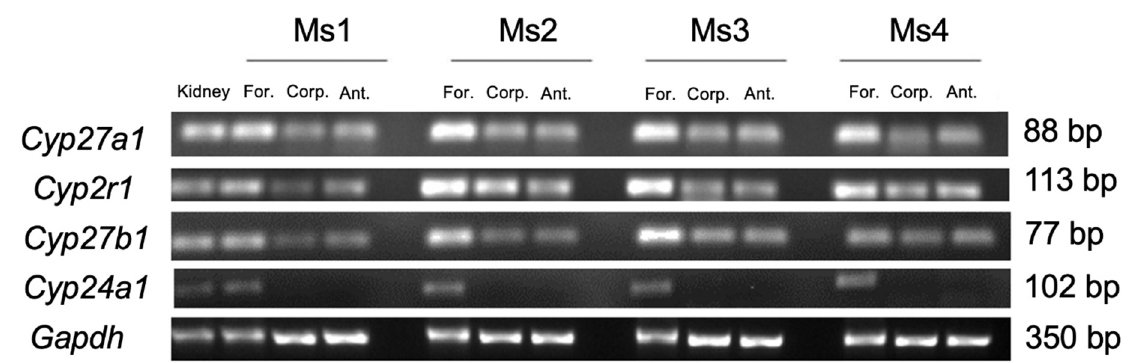
Figure 3. CYP enzyme expression in the stomachs of four 2–4-month-old normal mice ( n = 4). Cyp2r1 , Cyp27a1 and Cyp27b1 were expressed in the forestomach (For.), corpus (Corp.) and antrum (Ant.) with the highest expression observed in the forestomach. Cyp24a1 , which is responsible for VD degradation, was expressed only in the forestomach. Kidney RNA and Gapdh were used as positive controls and internal controls,